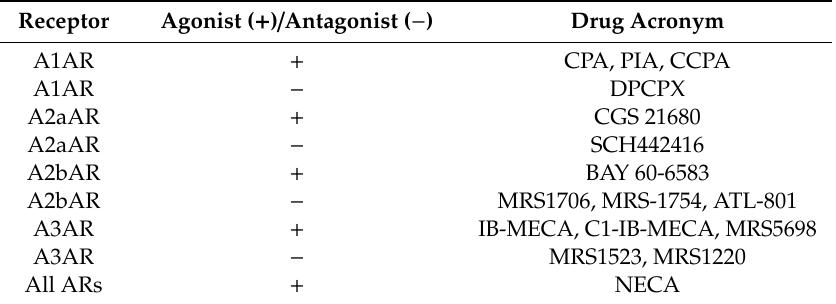
Table 1. Experimental agonists and antagonists of the adenosine receptors (see the abreviation section for drugs full